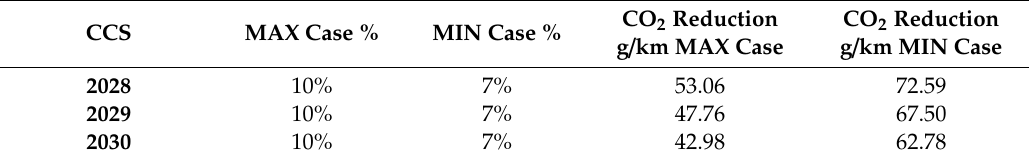
Table 9. CO 2 Reduction in Carbon Capture and Storage Technology.